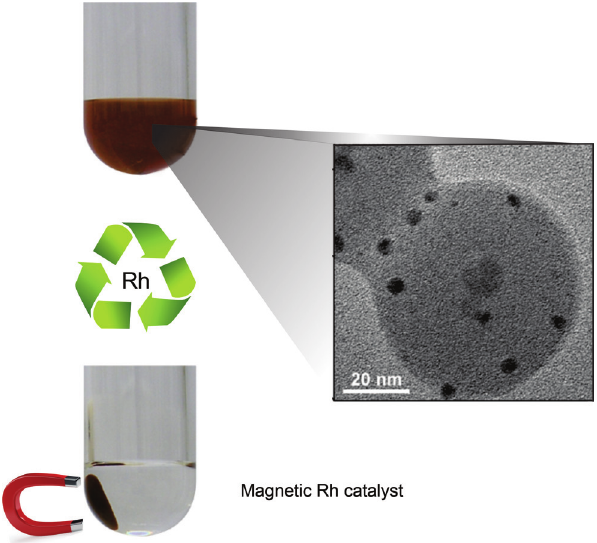
Figure 6 Magnetically recoverable Rh NPs immobilized on the surface of silica-coated iron oxide NPs and illustration of magnetic separation of the catalyst after catalytic reaction. Adapted from Ref. [39]. © 2008 With permission from